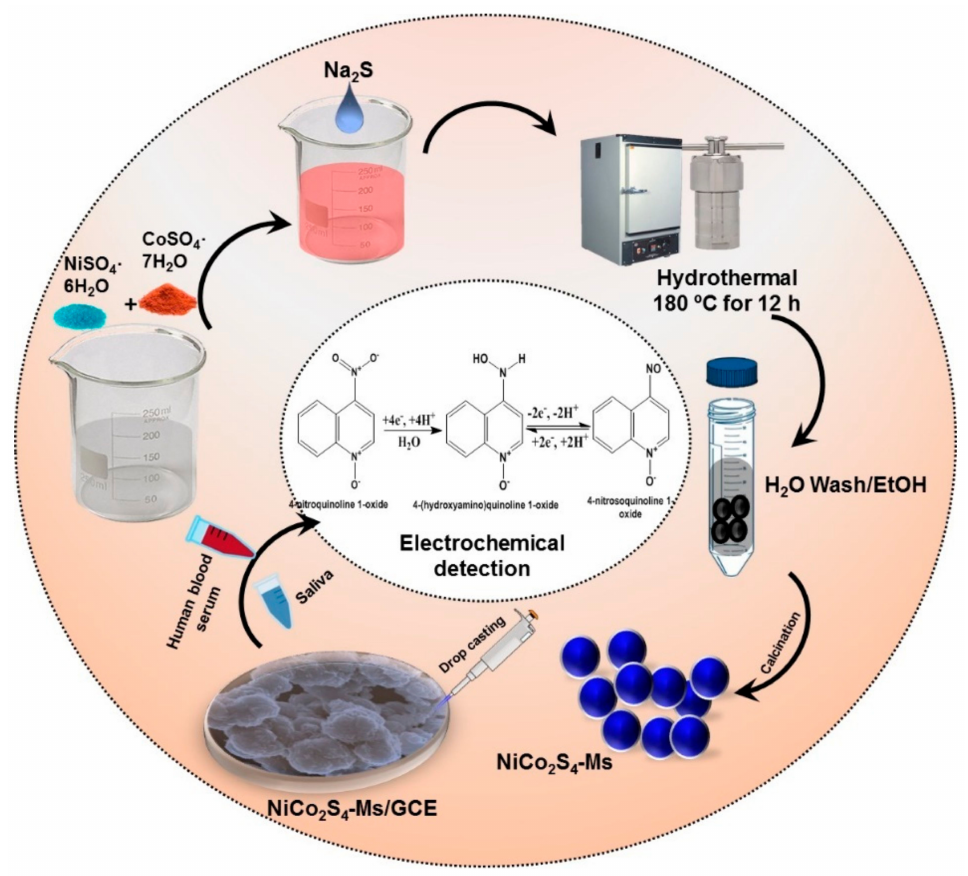
Scheme 1. Synthesis methodology of NiCo 2 S 4 -Ms and its electrocatalytic properties for the detection of 4-nitroquinoline